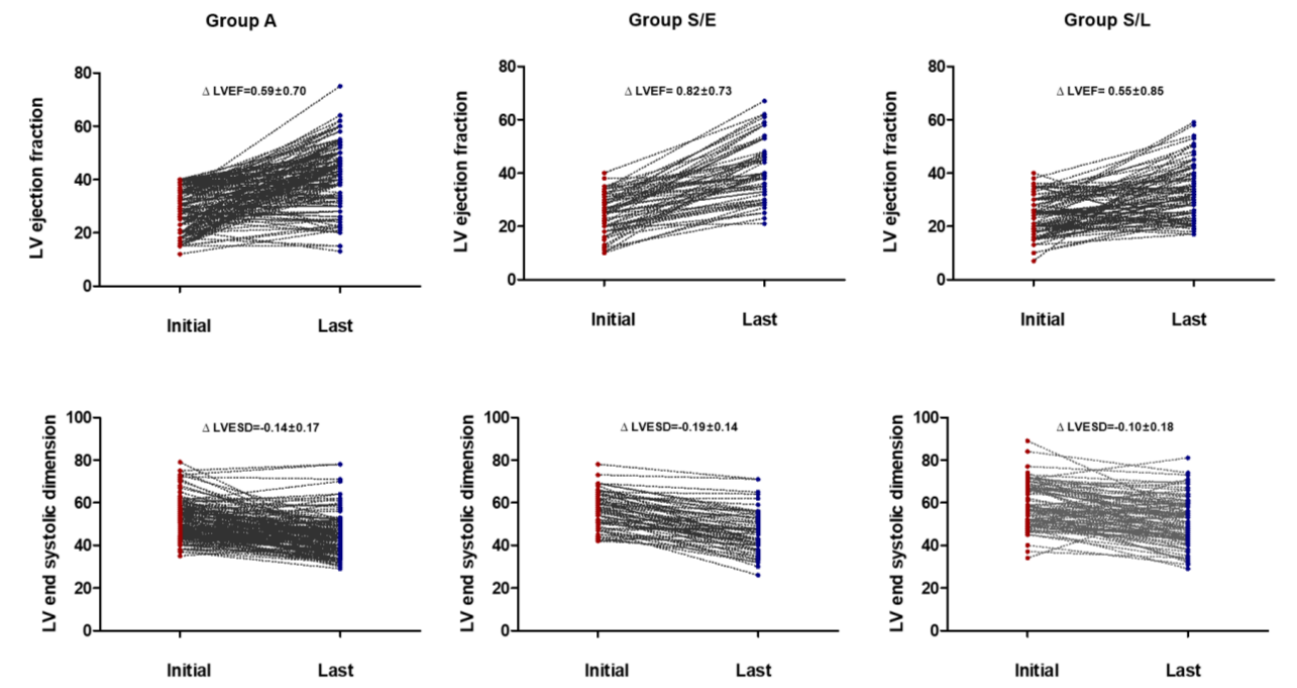
Figure 1. Changes in echocardiographic parameters from the initial diagnosis to the last follow-up.